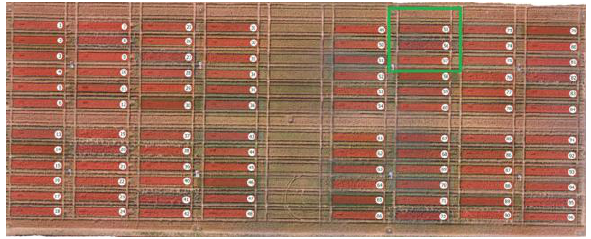
Figure 6. Field experiment. Test area in green